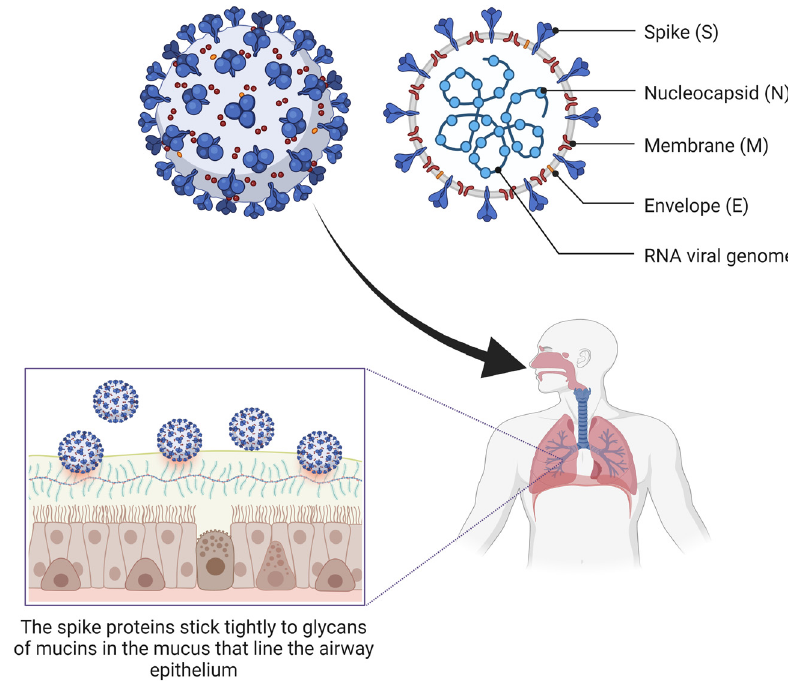
Figure 1: SARS - CoV - 2 structure and mechanism for remaining in the airways via spike